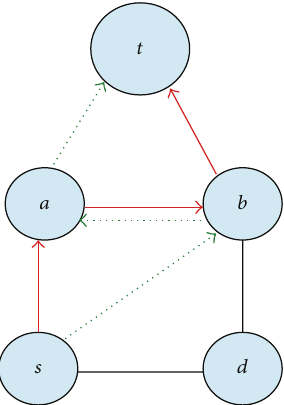
Figure 6: If for node 𝑠 , paths s-a-b-t (red solid) and s-b-a-t (green dotted) are given, then these paths will not both be included due to the conflict in the used direction of edge ab.